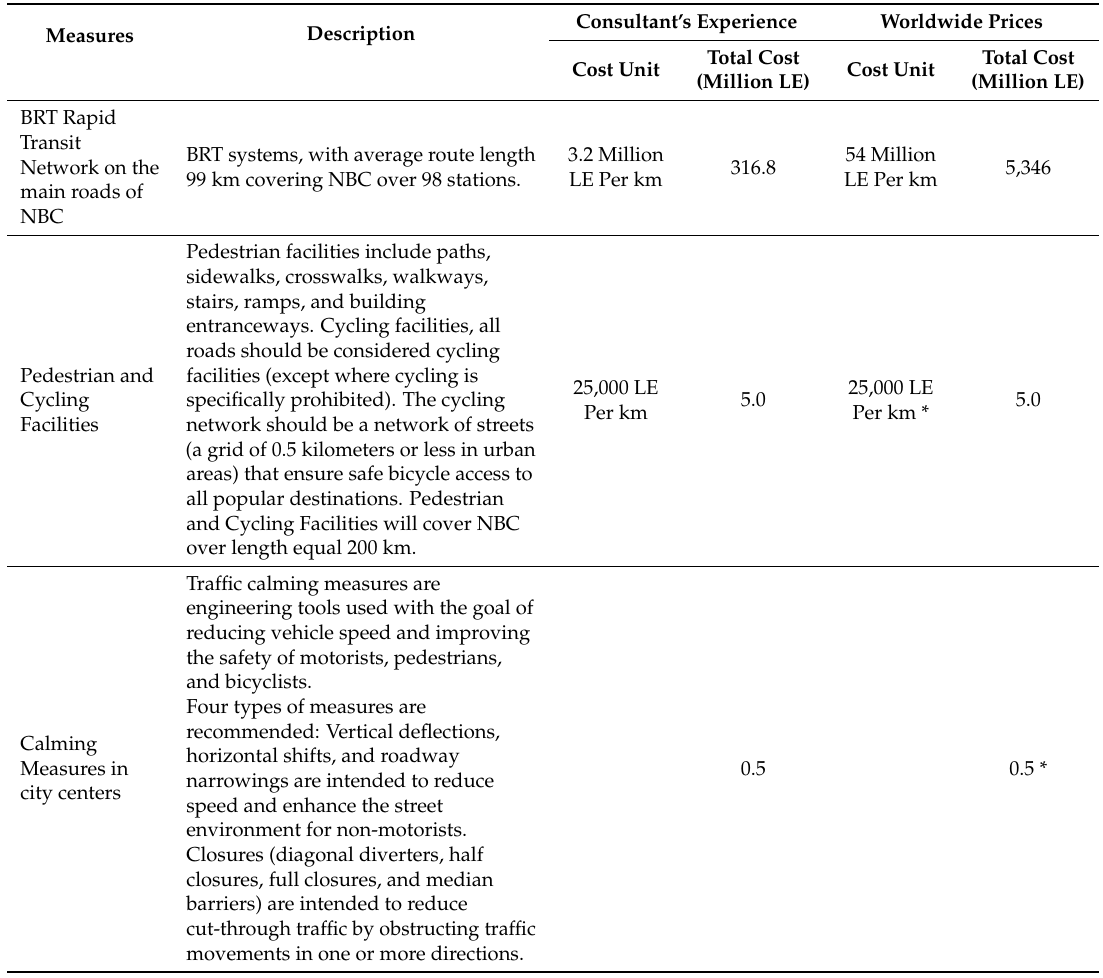
Table 5. Low Investment Sustainability scenario costs